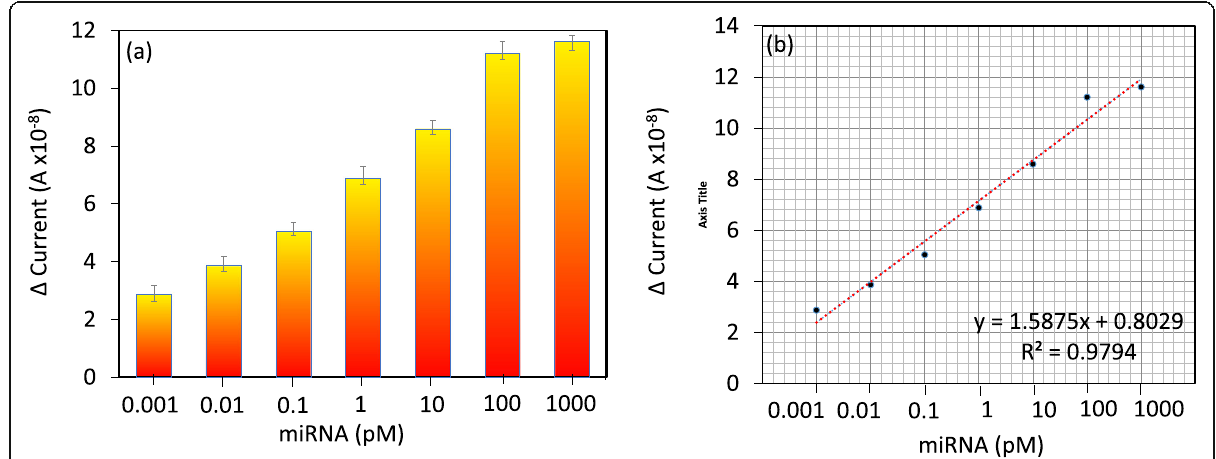
Fig. 5 Dose-dependency. a Dose-dependent interaction of miRNA-335-5p with the probe. b Linear regression analysis with different concentrations of miRNA-335-5p. LOD was considered the lowest concentration of an analyte against the background signal (S/N = 3:1)